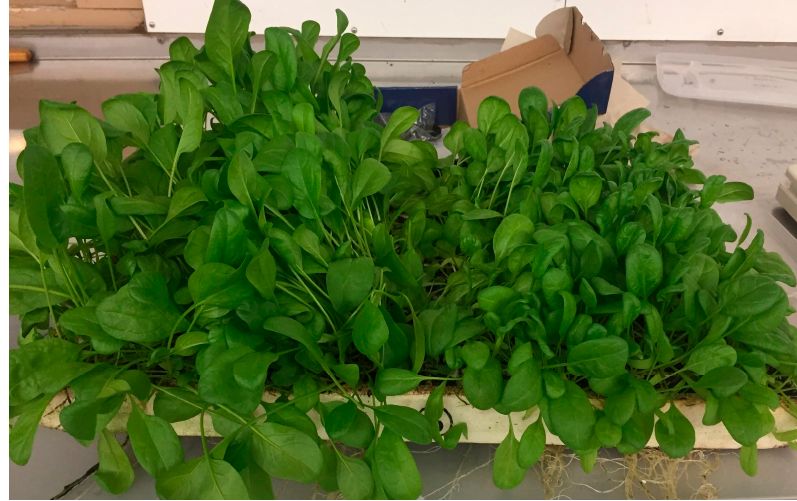
Figure 8. Carmel (left) and Seaside (right) at harvest illustrating the contrast between the long stems of Carmel and the short, bushy canopy of